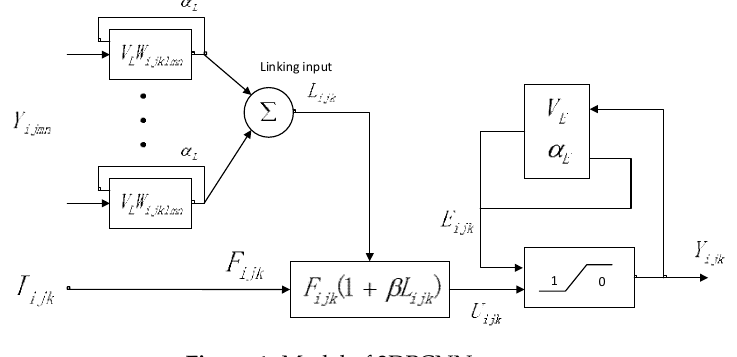
Figure 1. Model of 3DPCNN neuron.